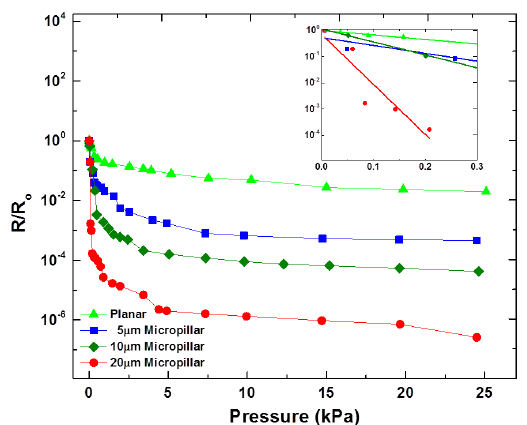
7 of 10 sensitivity of tactile sensor skins. However, untreated 20 μ m high vertical micropillars were liable to collapse during the repeated performance tests. Therefore, enhancement of stiffness of the micropillars must be used to prevent the collapse. The exposure of the MWCNT/PDMS film to Ar + ion beam irradiation leads to the generation of a thin silica-like stiff layer of nanometer scale dimensions [36]. This thin stiff layer on the exposed surface provides enough stiffness for 20 μ m vertical micropillars to withstand the repeated normal pressure providing the sensor durability. The lowered level of carbon concentration inside the surface layer after ion beam treatment can explain the increase of the initial resistance R o that eventually results in a higher R/R o change (higher sensitivity) under the same external pressure.